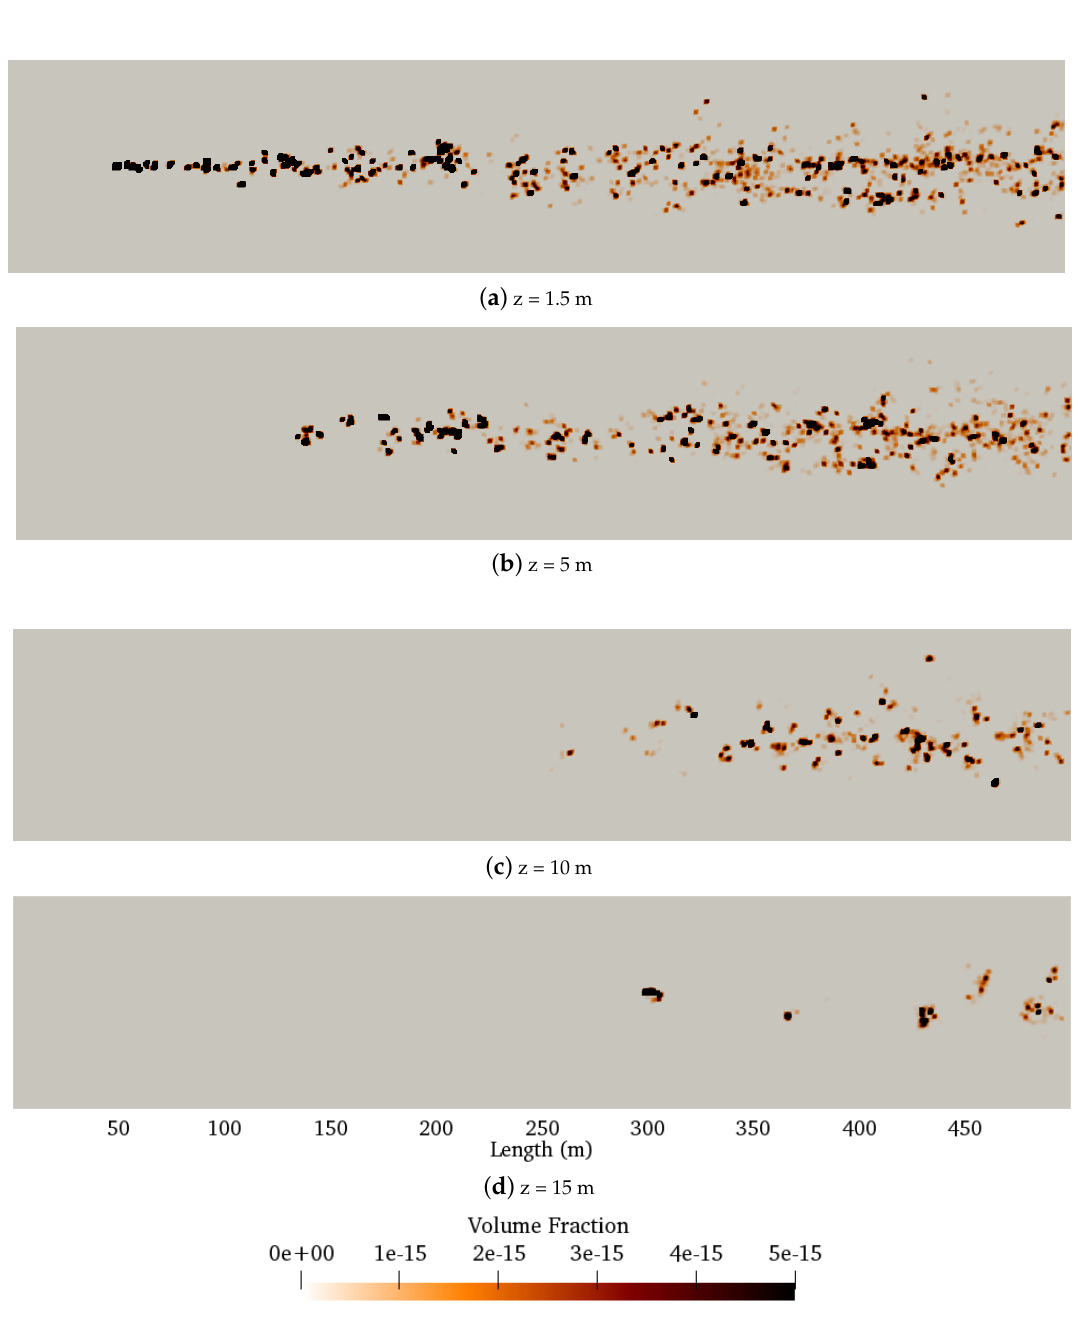
Figure 15. Volume fraction of PM10 for different heights at 120 s (top view of the domain with x axis along horizontal and y axis along